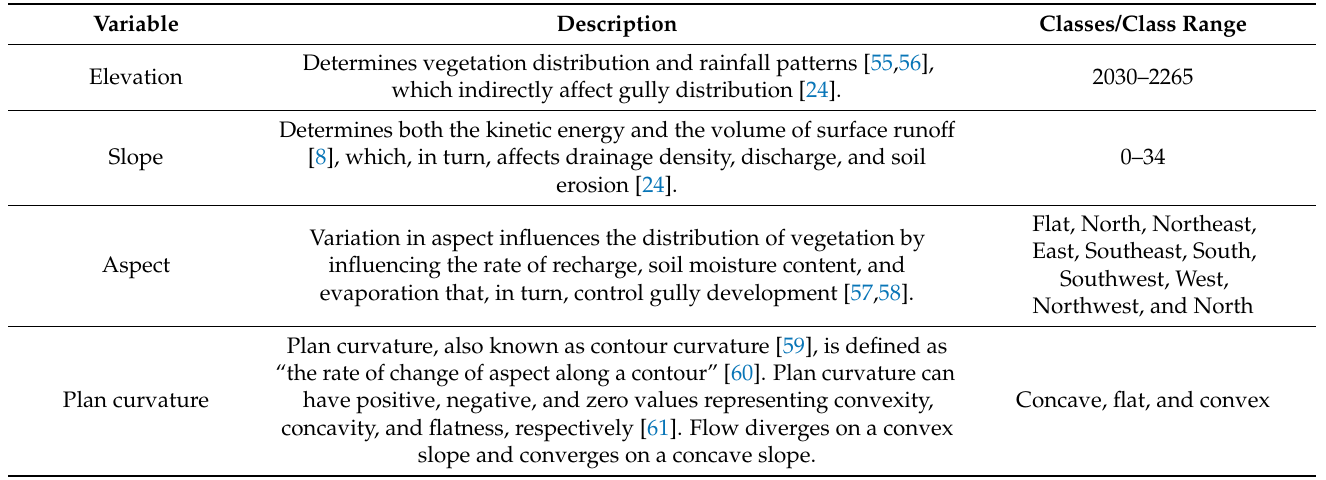
Table 2. Description of gully predictor